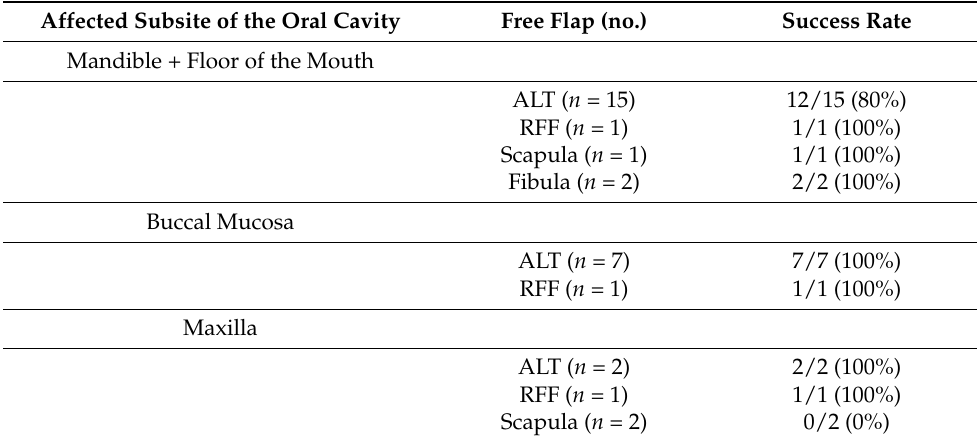
Table 2. Overview of reconstructive strategies and success rates in relation to affected anatomical subsite of the oral cavity.